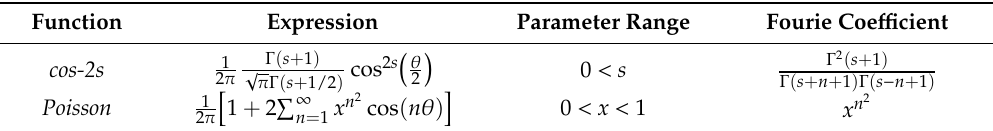
Table 3. Theoretical direction spreading